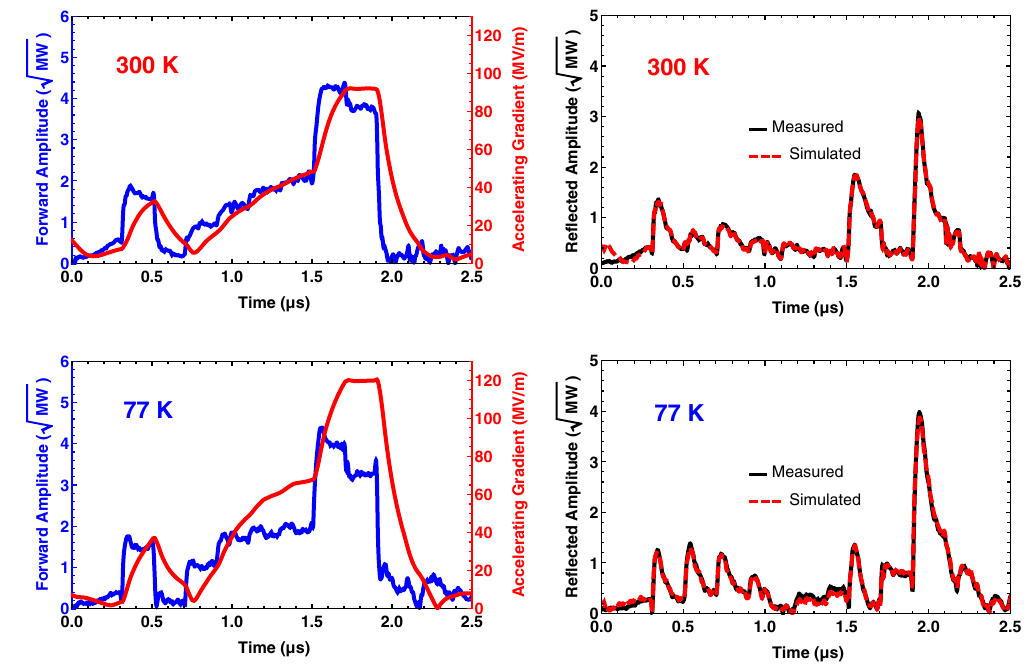
FIG. 8. The measured forward and reflected pulses at the input of the accelerator structure at a gradient of 95 and 120 MV = m for 300 and 77 K operation, respectively. The figure also shows the simulated gradient using the cavity model and the good agreement between measured and simulated reflected